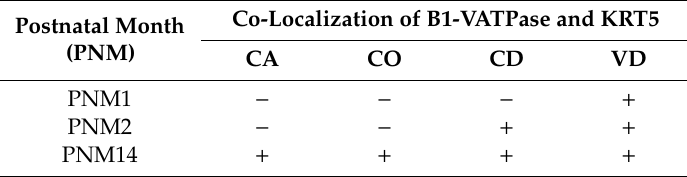
Figure 5. Co-localization of B1-VATPase and KRT5 in the goat epididymis and VD. Cells in the epididymis were double labeled for B1-VATPase (red) and KRT5 (green). ( A – D ) The epididymis at postnatal month (PNM) 1. ( E – H ) The epididymis at PNM2. ( I – L ) The epididymis at PNM14. The nuclei were labeled with DAPI (blue). The arrowheads indicate BCs double labeled for B1-VATPase and KRT5. Bars = 20 µ m. Table 1. Co-localization of B1-VATPase and KRT5 in the epididymis and VD of immature and mature goat.